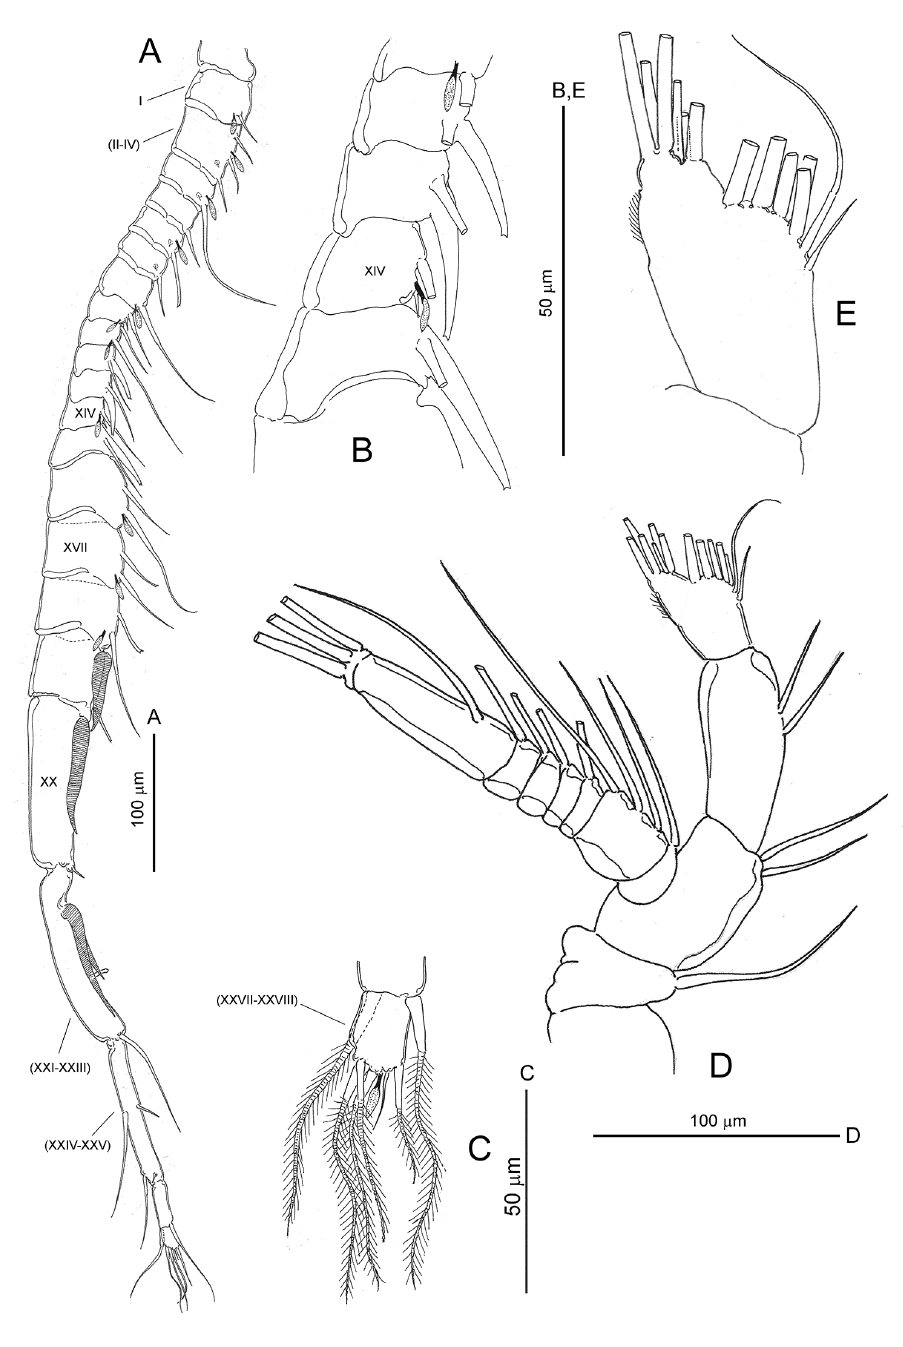
Figure 2. Notodiaptomus cannarensis sp. n. A male right antennule, ventral B detail of segments 10 to 13 of latter C inset of terminal segment D adult female right antenna, ventral E inset of terminal segment of